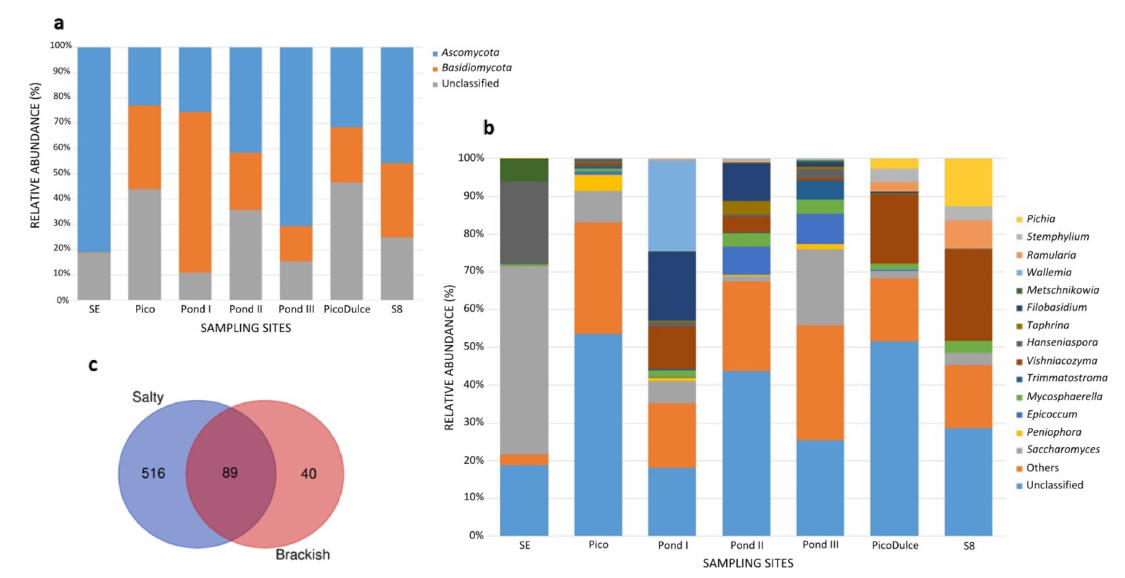
Figure 2. Relative abundance of the ( a ) phylum and ( b ) genera detected at the different locations analyzed in the saltern. Genera detected at <3% in all sampling sites are classified as Others; ( c ) Venn plot showing the share and exclusive genera between salty water location and brackish water location groups. SE, Santa